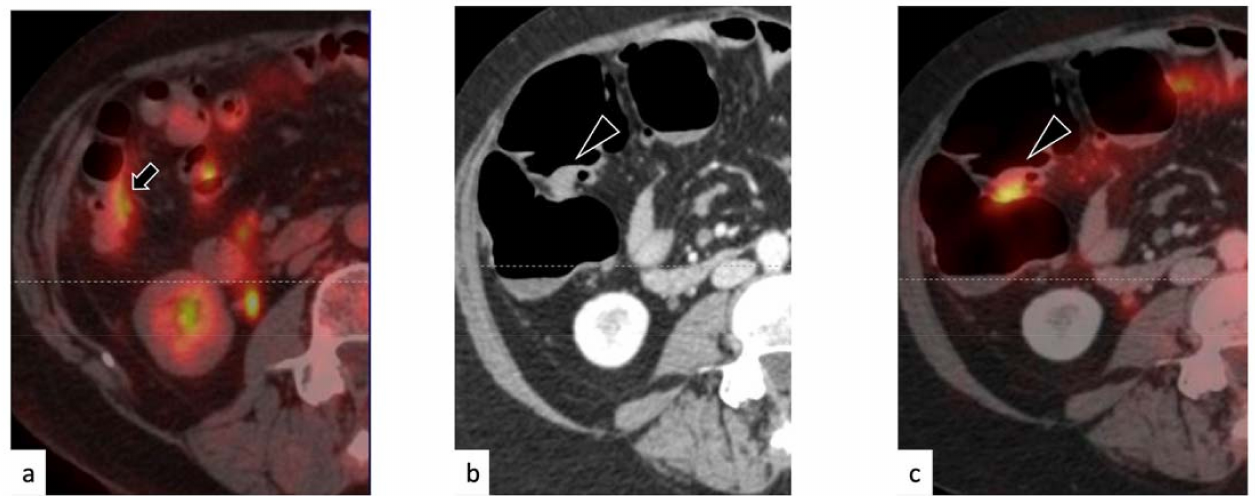
Figure 4. False-positive finding at positron emission tomography/contrast enhanced X-ray computed tomography PET/ceCT. The PET/ low dose (ld)CT ( a ) showed diffused, low-grade fluorodeoxyglucose (FDG) uptake within the ascending colon, which was deemed unspecific. However, the PET/ceCT ( b , c ) identified a seemingly nodular formation in the colic wall, with intensive FDG uptake. At further follow-up, the uptake disappeared without treatment, and the nodular formation was revealed as an artefact, due to abdominal